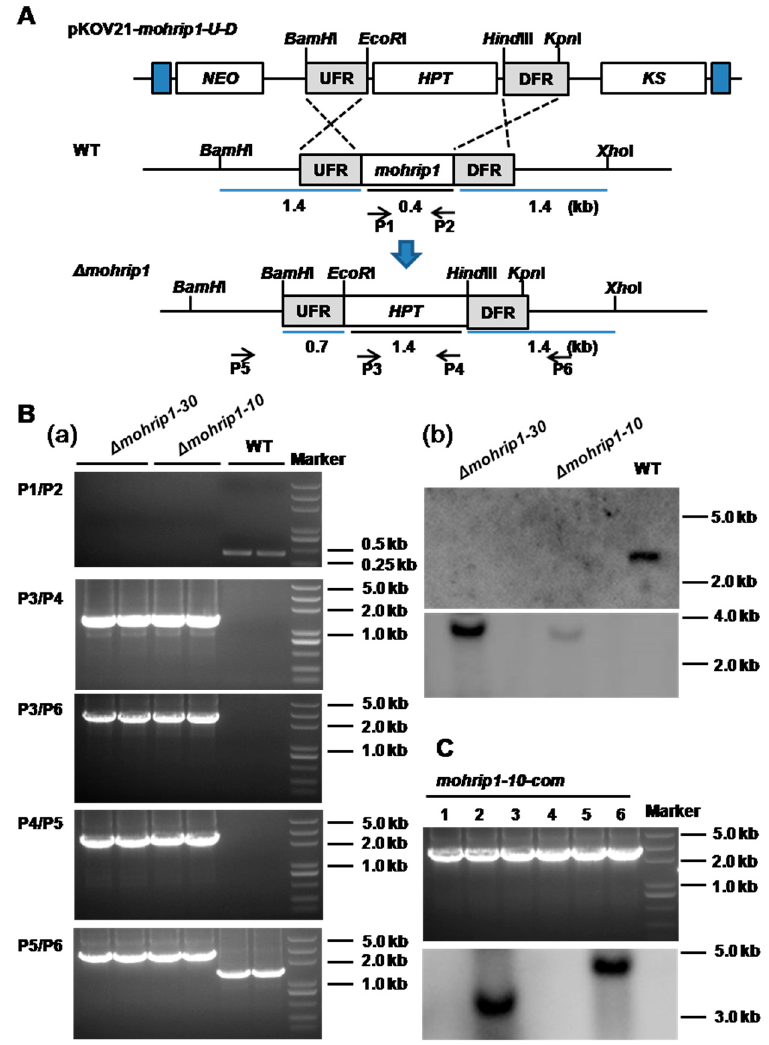
Figure 2. Construction and confirmation of mohrip1 deletion and complementation mutants. ( A ) Deletion of mohrip1 according to homologous recombination. pKOV21 -mohrip1-U-D , knockout vector for mohrip1 ; WT, pattern of mohrip1 in the genome of M. oryzae ; Δ mohrip1 , deletion mutants containing HPT gene replacing mohrip1 ; UFR, upstream flanking region of mohrip1 ; DFR, downstream flanking region of mohrip1 . Values represent the size of corresponding fragments. P1 to P6 were six primers used for the mutant confirmation by PCR. ( B ) Confirmation of the deletion mutants. ( a ) PCR confirmation; ( b ) Southern Blot validation using mohrip1 ( upper ) and HPT ( lower ) probes; ( C ) Confirmation of several independent complementation strains by PCR ( upper ) and Southern Blot ( lower ) with mohrip1 probe. The 1—6 were six complementation strains confirmed by PCR, from which two strains were chosen for Southern Blot. One strain named mohrip1-10-com was randomly selected for the subsequent bioassays. ∆ mohrip1-10 , ∆ mohrip1-30 , mohrip1-10-com and WT respectively represent the two deletion mutants, one complementation mutant and the wild type strain.